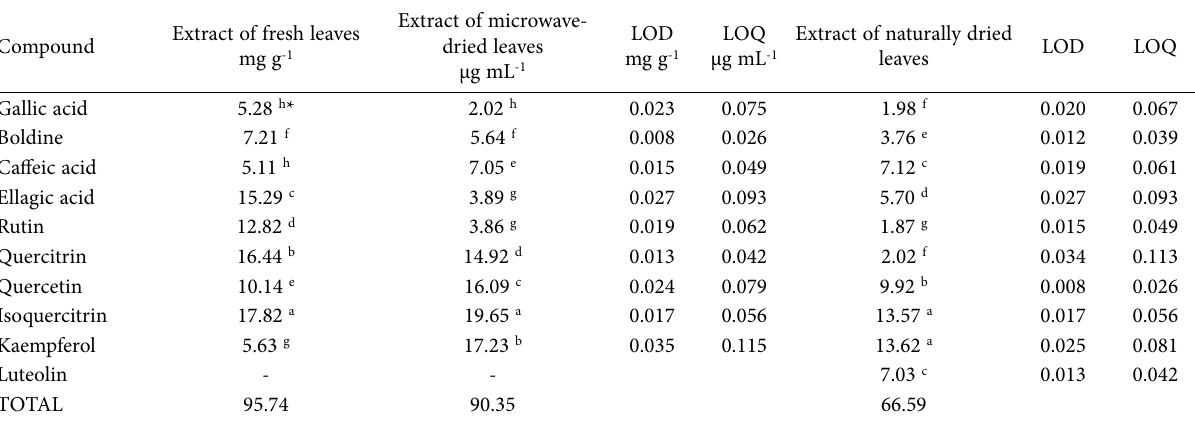
Results are expressed as mean of three determinations. LOD is the limit of detection and LOQ is the limit of quantification. * Means fol- lowed by different letters differ by the Scott-Knott test (p <0.01).